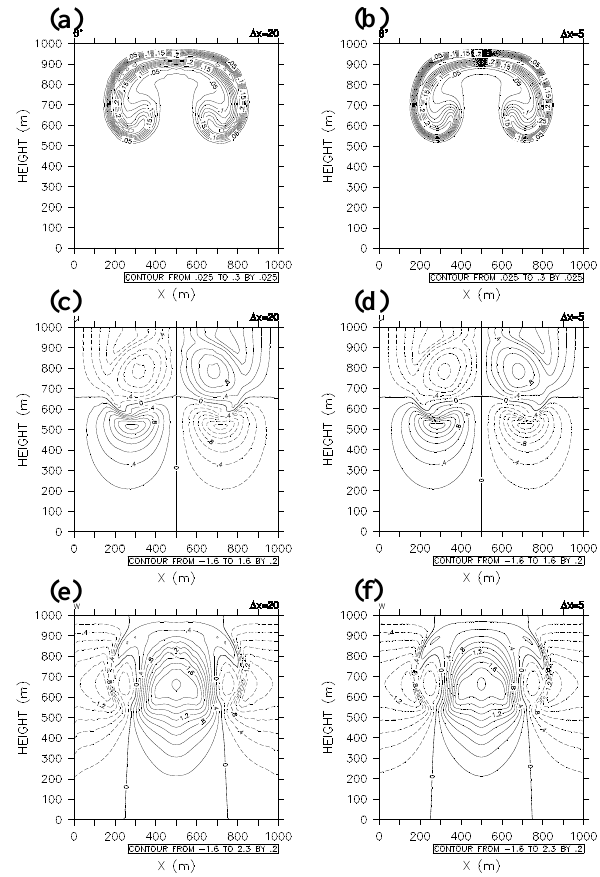
FIG. 11. Plots of (a, b) potential temperature perturbation (K), (c, d) horizontal wind 2 Figure 11. Plots of (a, b) potential temperature perturbation (K), (m/s), and (e, f) vertical wind (m/s) for the rising thermal bubble test after 700 s with (left) 3 (c, d) horizontal wind (ms − 1 ), and (e, f) vertical wind (ms − 1 ) for the rising thermal bubble test after 700s with (left) (cid:49) ¯ x,(cid:49) ¯ z = 20m , 20x z ∆ ∆ = m and (right) , 5x z ∆ ∆ = m resolution for the rising thermal bubble test. All 4 and (right) (cid:49) ¯ x,(cid:49) ¯ z = 5m resolution for the rising thermal bubble simulations use 5th-order basis polynomials per element. Negative values are denoted by 5 test. All simulations use fifth-order basis polynomials per element. dashed lines and positive values are denoted by solid lines. 6 Negative values are denoted by dashed lines and positive values are denoted by solid